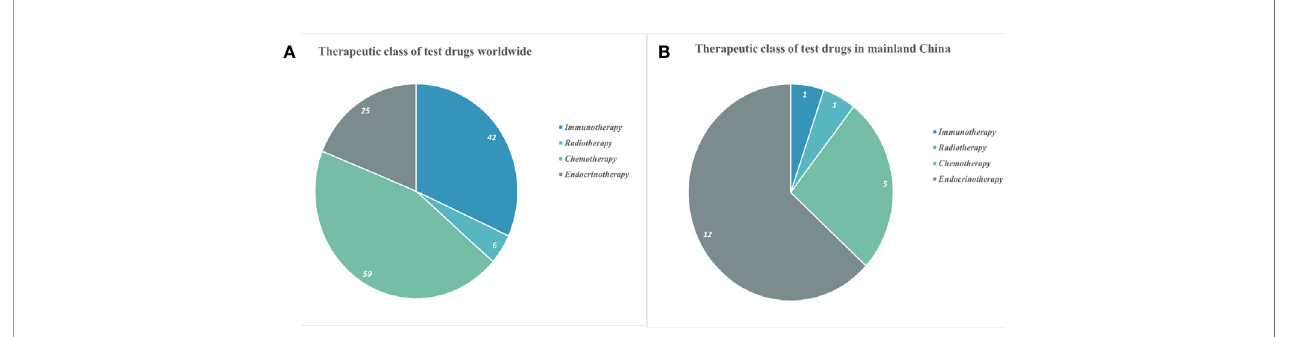
FIGURE 2 | Classi fi cation of drugs in clinical trials for prostate cancer worldwide (A) and in mainland China (B)